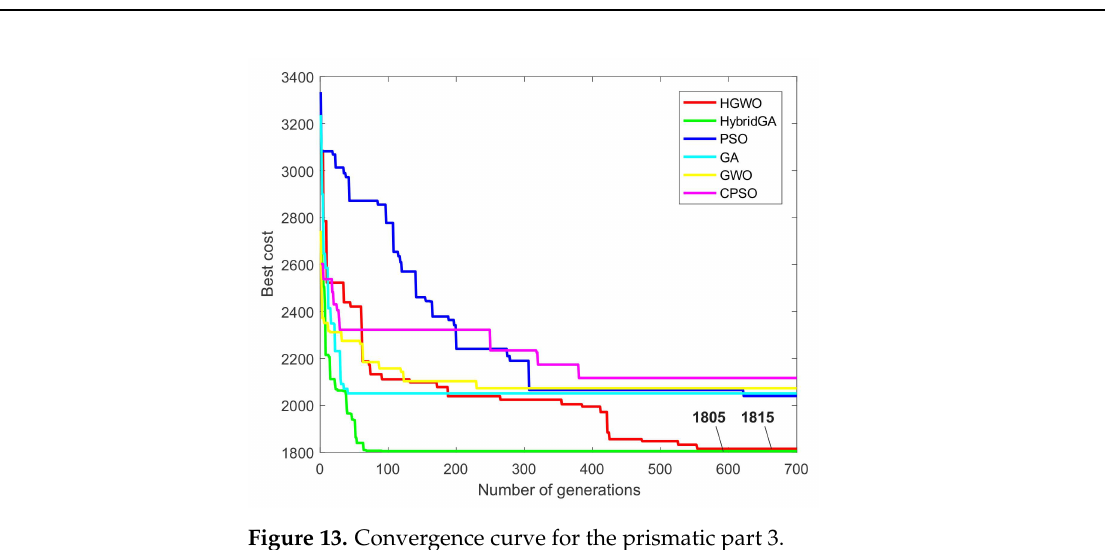
Figure 13. Convergence curve for the prismatic part